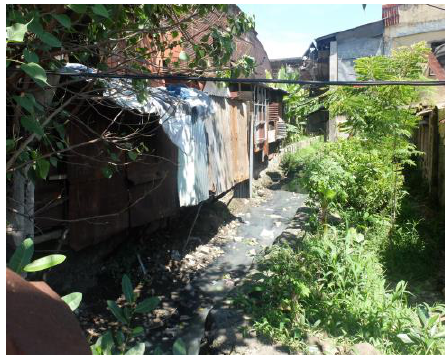
Figure 17. A small creek on the south side of Tinago. This creek does not appear in Google Maps.